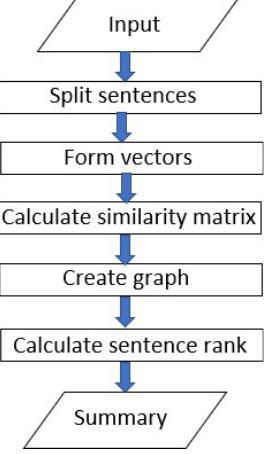
Fig. 5 Graphical comparison between results